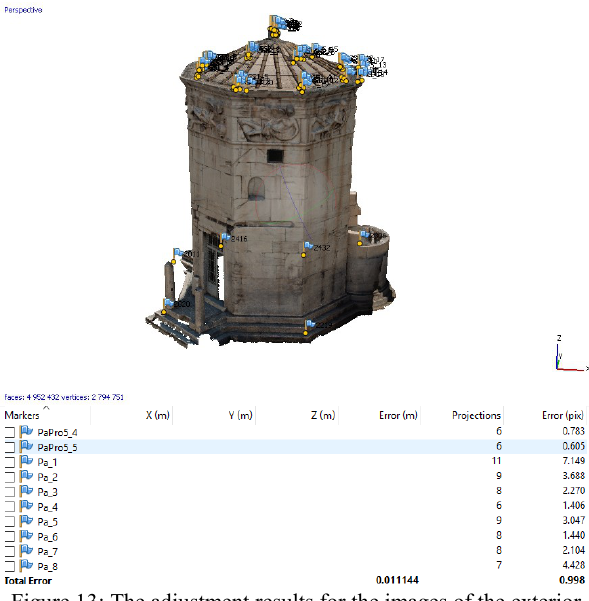
Figure 13: The adjustment results for the images of the exterior